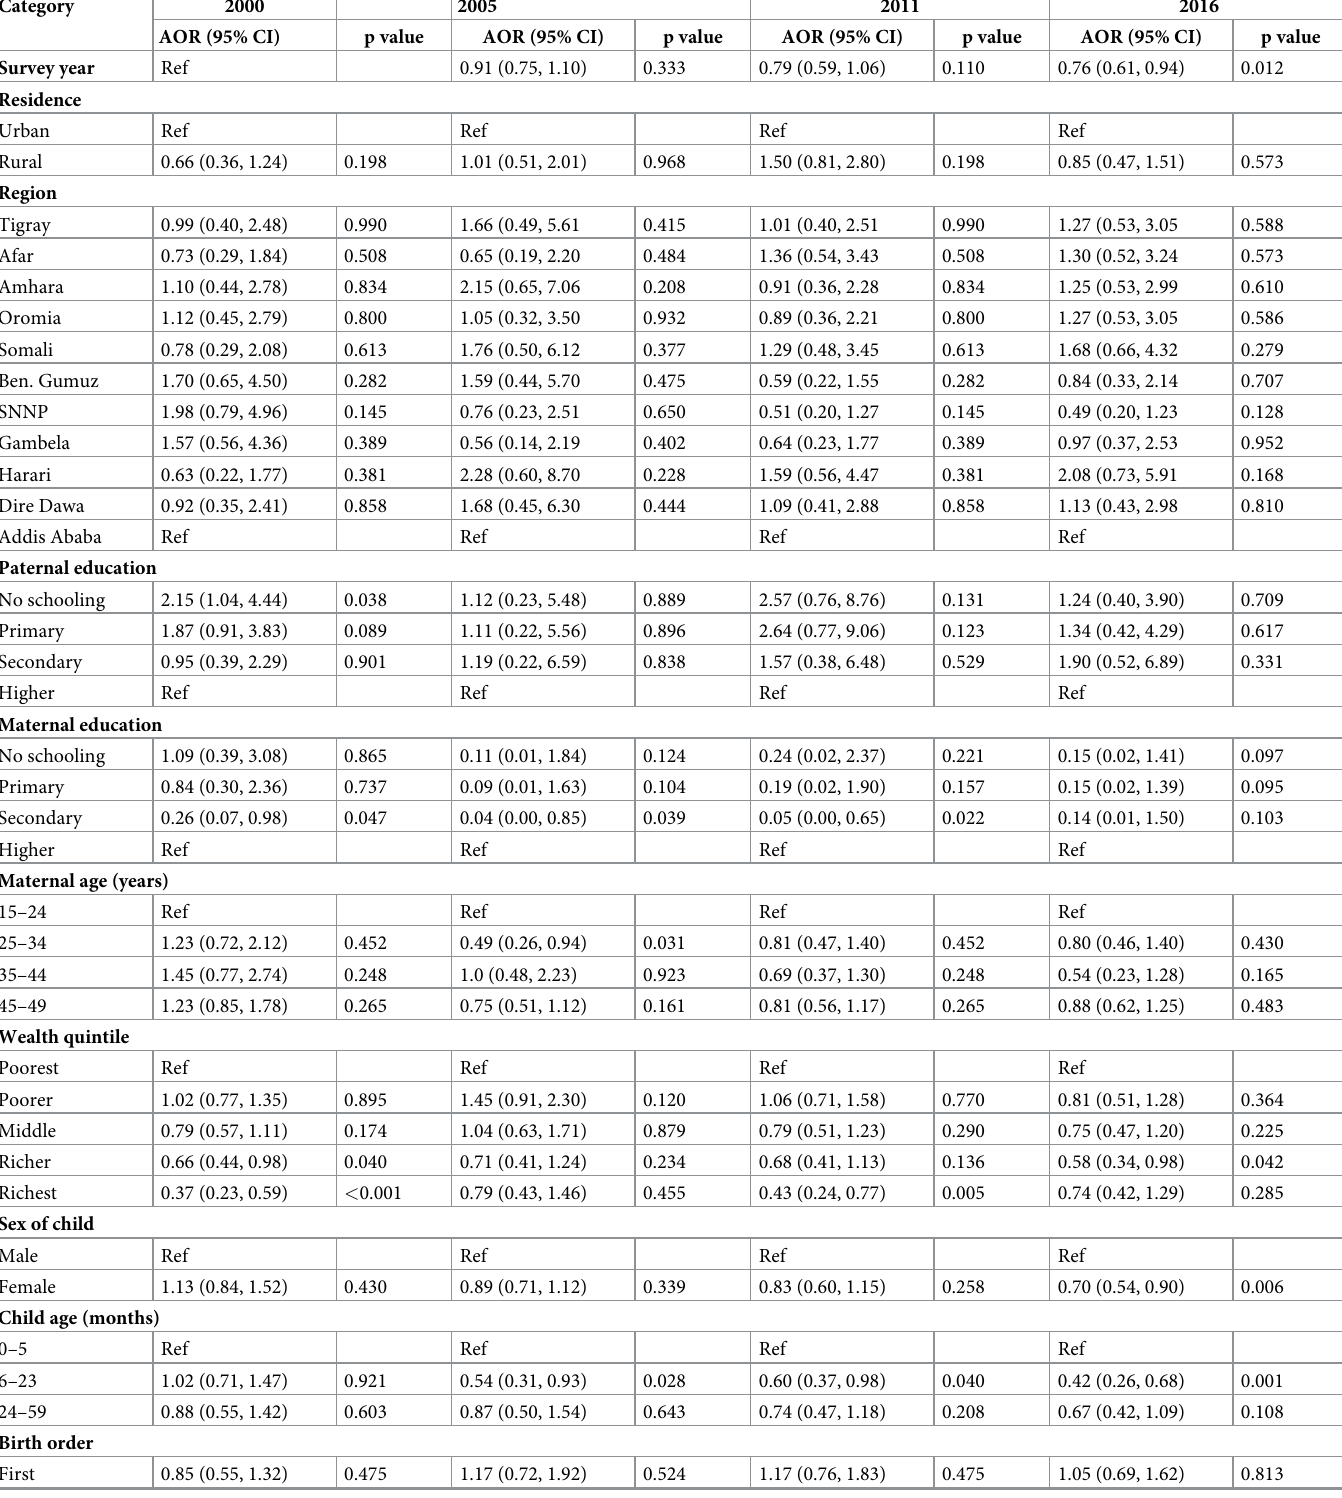
Table 4. Trends in adjusted odds ratios for wasting, EDHS 2000 to 2016.